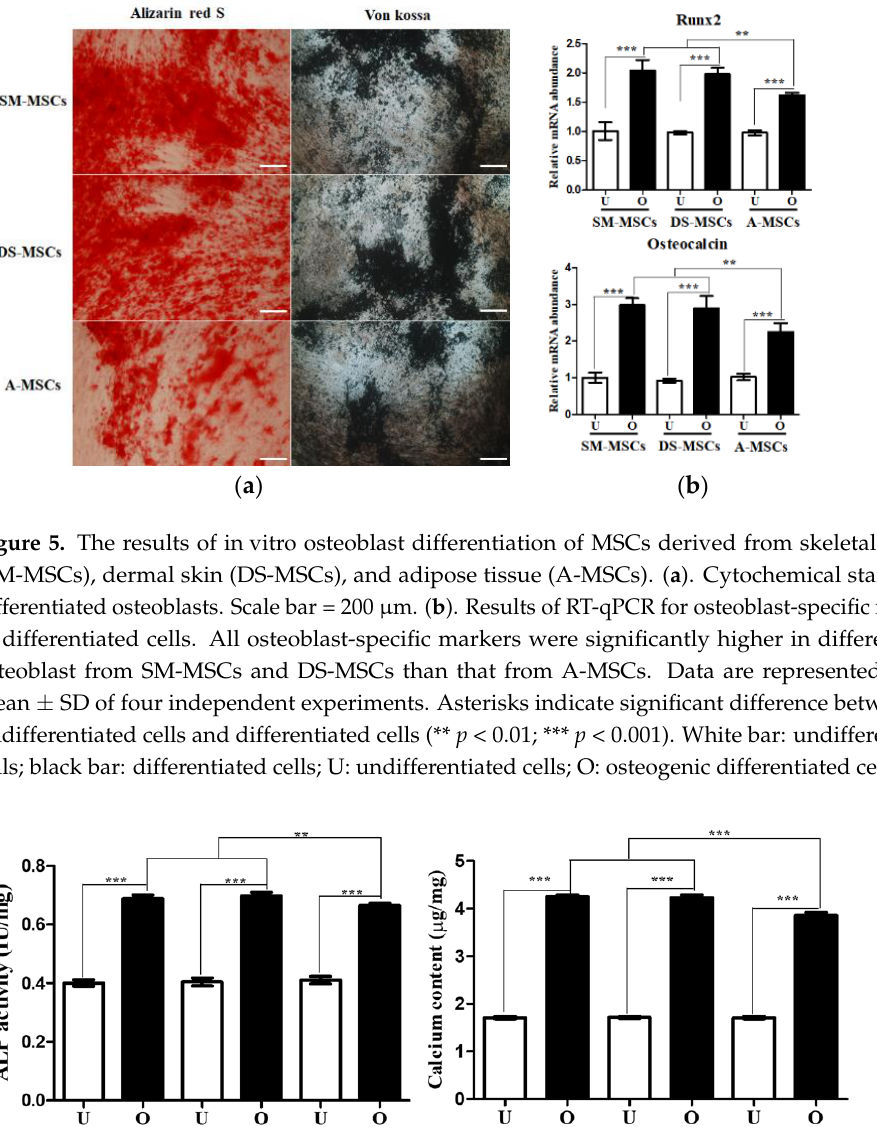
( b ) Figure 4. In vitro mesoderm-lineage (adipocyte and chondrocyte) differentiation of MSCs from three types of tissues. ( a ). Adipocytes and chondrocytes differentiation were confirmed oil red O (for adipocytes) and Alcian blue (for chondrocytes) staining. ( b ). The gene expression of adipo- cytes and chondrocytes-specific markers in differentiated cells. Data are represented by the mean ± SD of four independent experiments. Asterisks indicate significant difference between the undif- ferentiated cells and differentiated cells (*** p < 0.001). White bar: undifferentiated cells; black bar: differentiated cells; U: undifferentiated cells; A: adipogenic differentiated cells; C: chondrogenic differentiated cells. 3.3. In Vitro Osteogenic Differentiation Capacity of MSCs The SM-MSCs, DM-MSCs, and A-MSCs were successfully differentiated into osteo- blasts. The calcified extracellular matrix formation was confirmed by Alizarin red S, and Von kossa staining (Figure 5a). The expression of osteoblast-specific markers (Runx2, and Osteocalcin) was significantly higher in the osteogenic-induced MSCs than the non-dif- ferentiated cells (Figure 5b). Additionally, upon the induction of osteogenesis, the expres- sion of Runx2 and Osteocalcin was significantly ( p < 0.01) higher in SM-MSCs and DS-